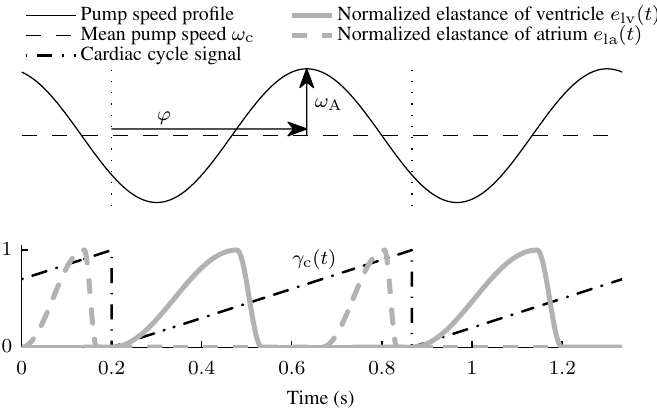
Figure 2. Timing of the sinusoidal speed profile with respect to the cardiac cycle. The start of a cardiac cycle was defined as the onset of the ventricular systole (dotted vertical lines). At these instants, the cardiac cycle signal, γ ( t ) , which was used to generate the sinusoidal c speed profile, is reset. For the sinusoidal speed profiles, the two parameters, ϕ (phase shift) and ω (amplitude), are defined. A Normalized elastance of ventricle e lv ( t Normalized elastance of atrium e la ( t ) ω A ϕ